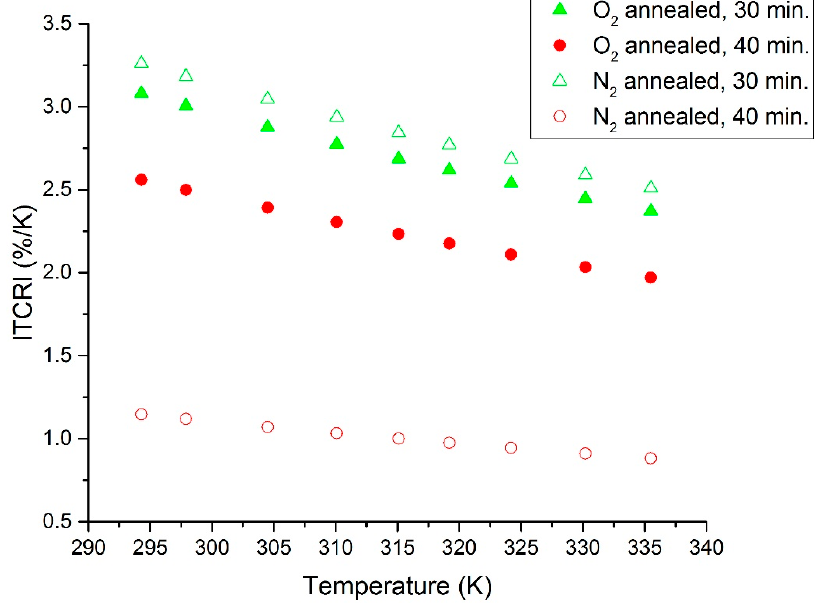
Figure 7. | TCR | versus temperature plot for O 2 - and N 2 -annealed resistive thermometers.